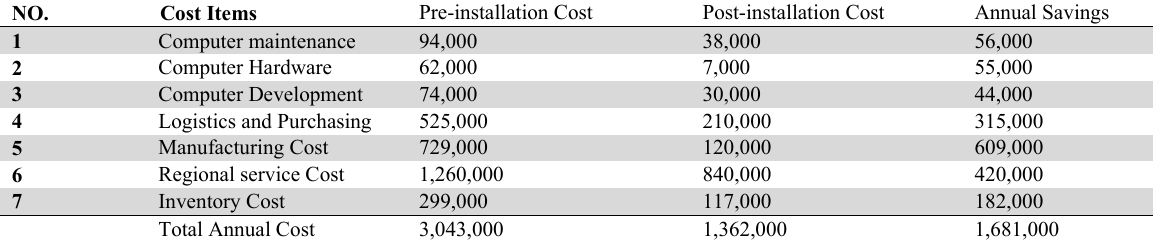
Cost comparison of Pre-installation and Post-installation ERP